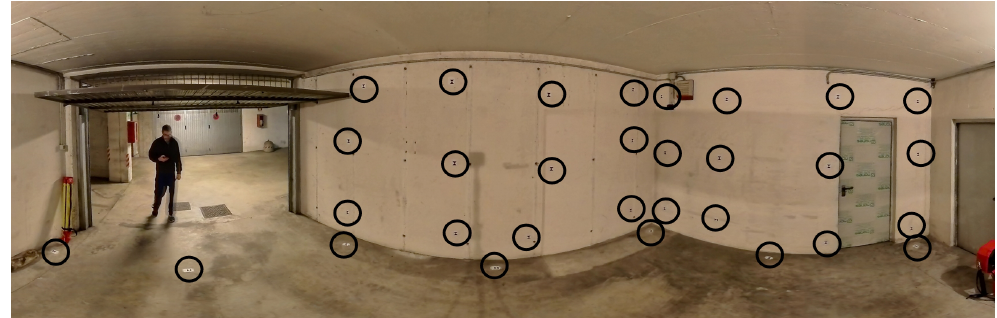
Figure 7. The reference object made up of three orthogonal surfaces measured with a single spherical image, which was partially cropped in this